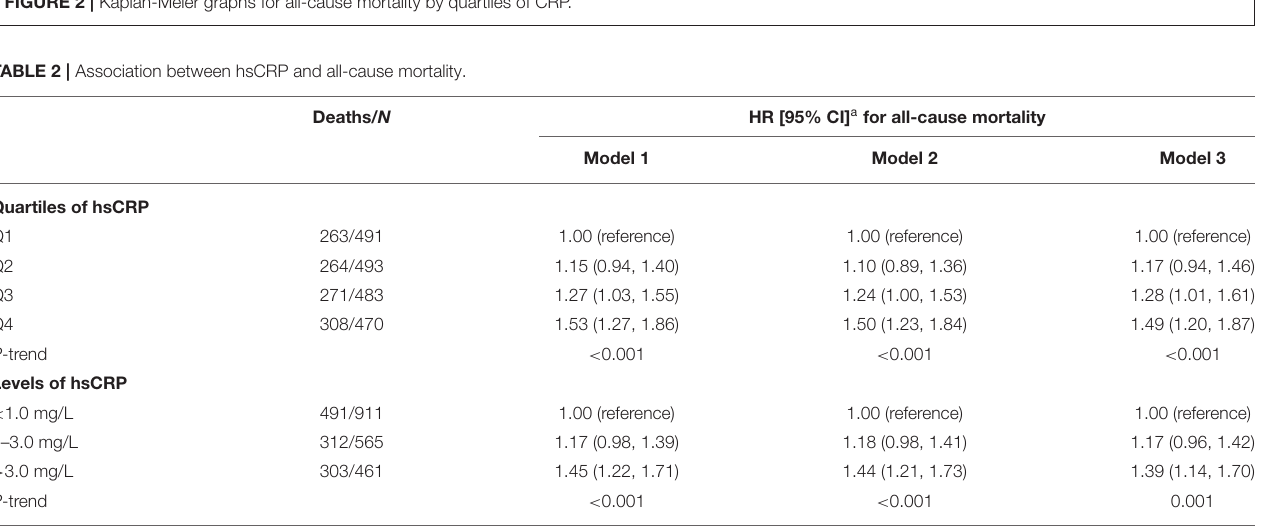
TABLE 2 | Association between hsCRP and all-cause mortality.